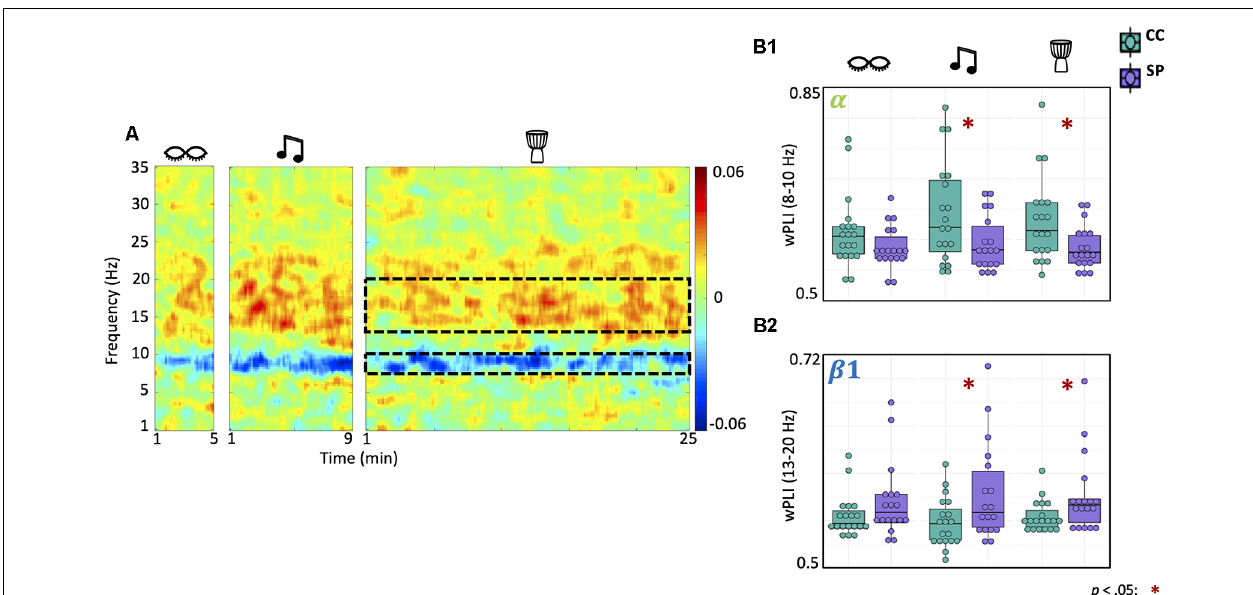
FIGURE 4 | Shamanic practitioners have increased low beta and decreased low alpha connectivity during drumming and classical music. (A) Differences in functional connectivity, measured by weighted Phase Lag Index (wPLI), between shamanic practitioners (SP; n = 18) and control participants (CC; n = 19). Warmer colors represent greater connectivity in SP while cooler colors indicate greater connectivity in CC. The dotted lines represent the low alpha (8–10 Hz) and low beta (13–20 Hz) frequency bands, which were significantly different between groups. (B1,B2) Box plots illustrating the average wPLI in the low alpha (B1) or low beta (B2) frequency bands in SP (purple) and CC (green) during eyes closed, drumming, and music. Whiskers represent the lower (25%) and upper (75%) quartiles and the center band of each box represents the median for the group. SP experienced statistically significant decreases in wPLI in the low alpha band during classical music and drumming compared to CC (B1) , as well as statistically significant increases in the low beta band (B2) . Significance is indicated by the key in the lower righthand corner of the